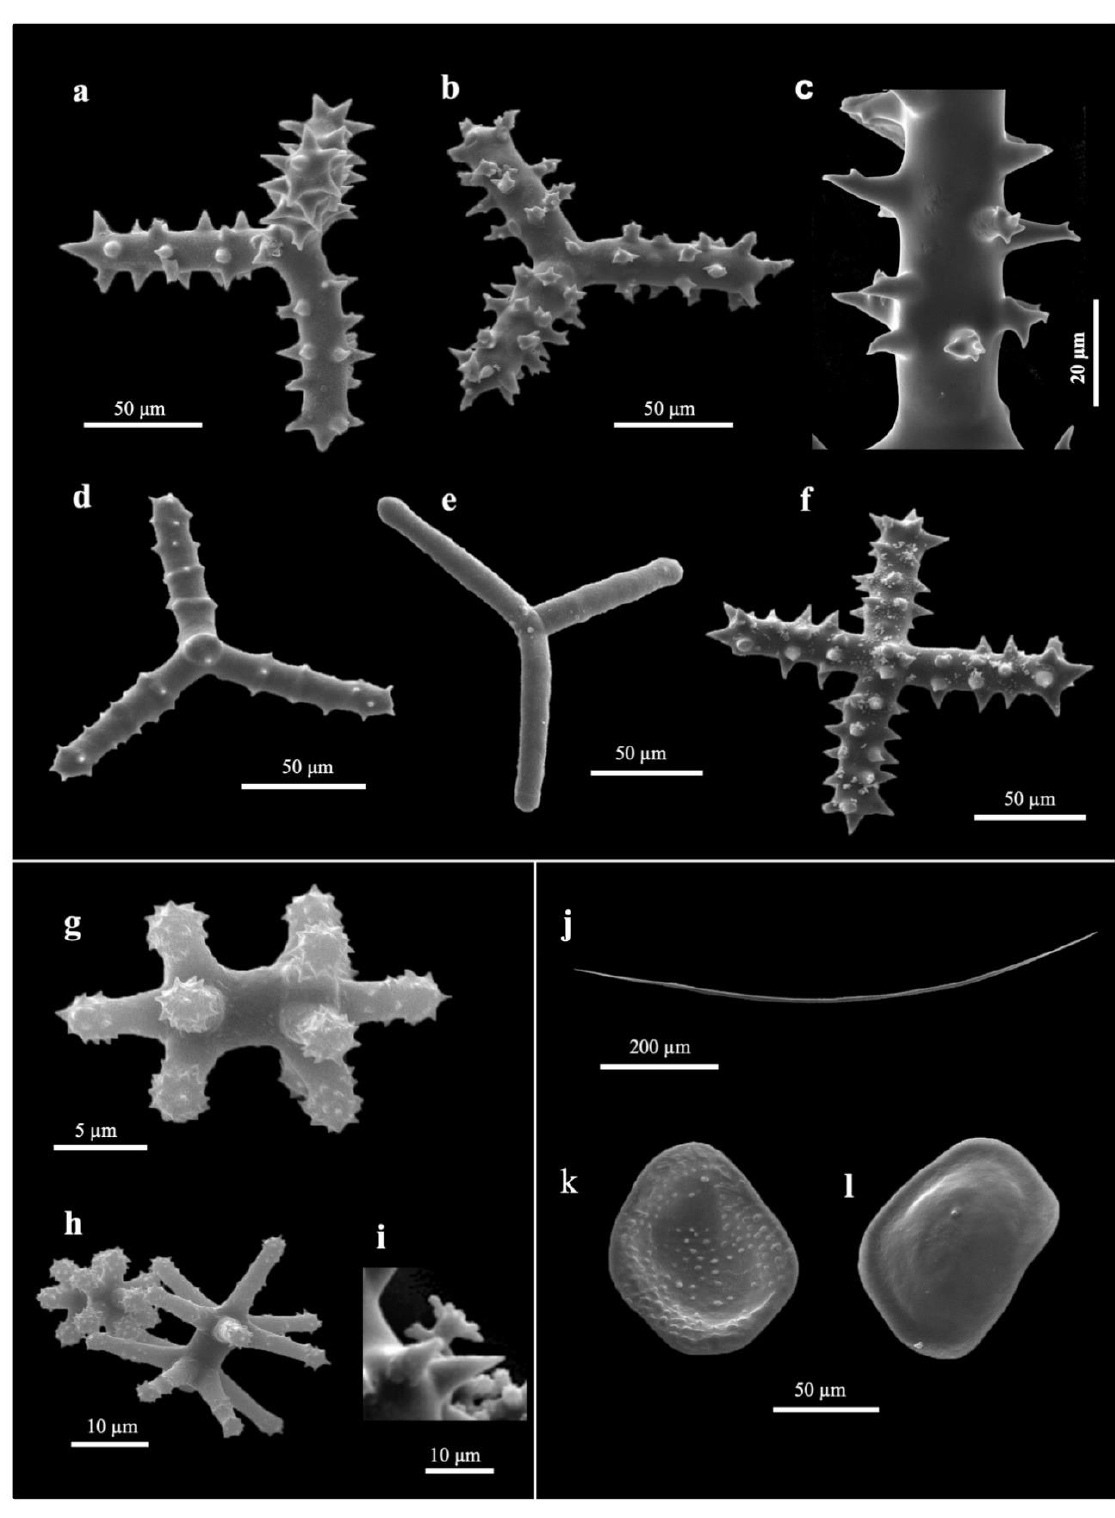
Figure 5. Spicule composition of Alectona ricardi sp. nov. present in the red coral sample. SEM images: ( a , b ) triactines covered by triangular spines; ( c ) magnification of a ray showing the compound spines; ( d ) slightly spined triactine with spines clearly organised in verticils; ( e ) smooth triactine; ( f ) triactine with four rays; ( g ) nodular amphiaster; ( h ) nodular amphiaster (in the background) and thinner amphiaster; ( i ) very small amphiaster; ( j ) oxea of an armed larva; ( k ) outer surface of a quadrangular discotriaene; ( l ) inner surface of a quadrangular discotriaene.